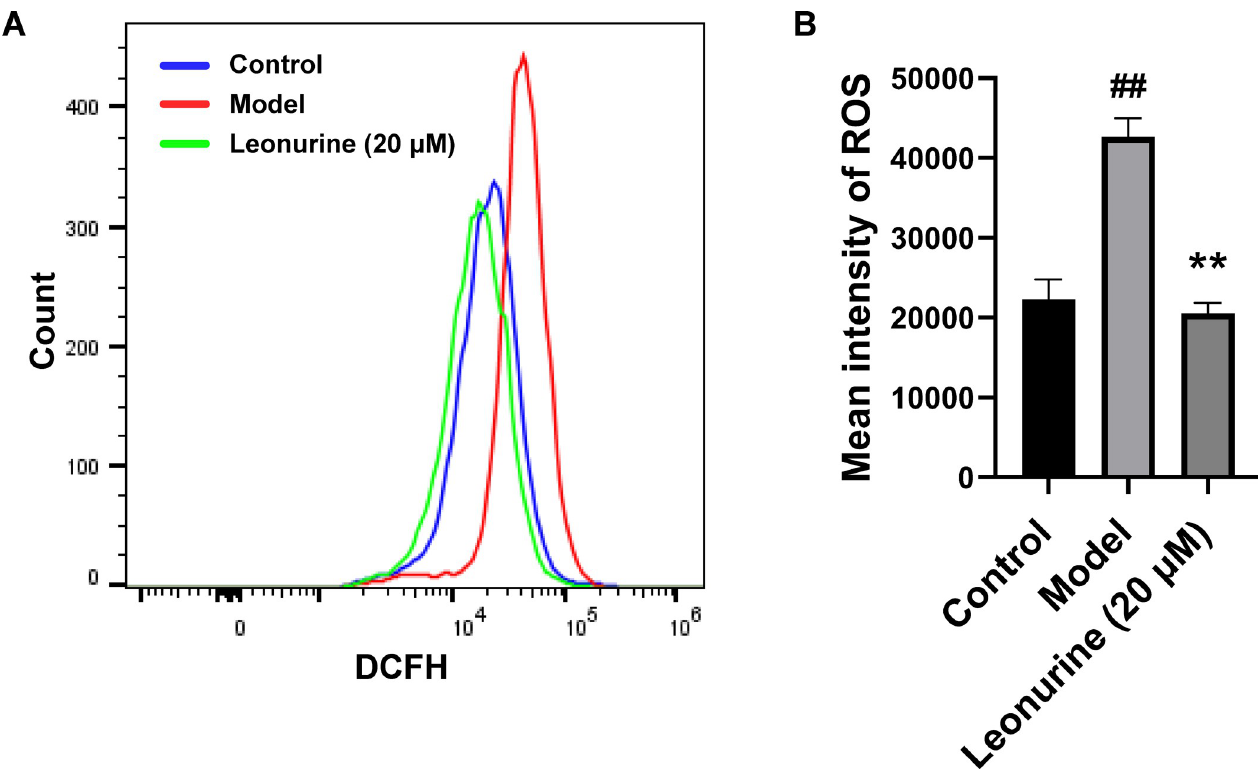
Fig 8. Leonurine decreased ROS production by flow cytometric detection in H9c2 cells stimulated by TGF- β . DCFH-DA was used to evaluate the intracellular ROS level. DCFH-DA is a nonfluorescent ester of the dye fluorescent product in the presence of ROS. (A) The peak value of the model group shifted to the right, and the peak value of the leonurine group shifted to the left. (B) ROS production increased with TGF- β exposure, and pretreatment with leonurine inhibited the ROS increase after TGF- β stimulation. ##P < 0.01, model group vs. control group; �� P < 0.01, 20 μ M leonurine group vs. model group. DCFH-DA, 2,7-dichlorofluorescein